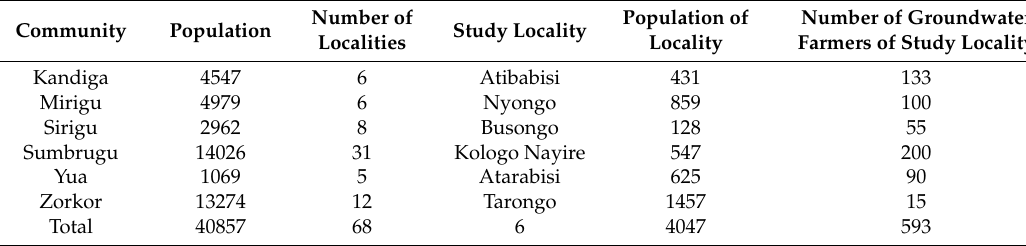
Table 1. Population statistics of